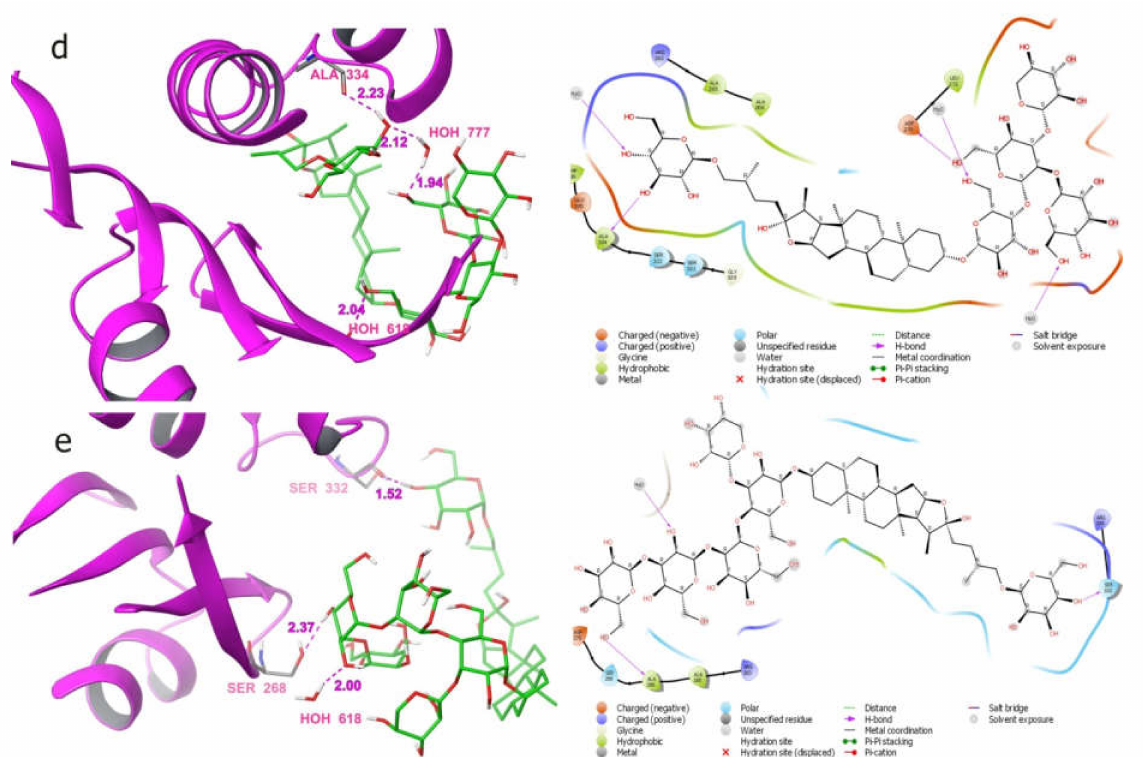
Figure 8. Sativoside R2 ( a ), Degalactotigonin ( b ), and Eruboside B ( c ) interaction map with the protein anthranilate phosphoribosyltransferase (3R6C); Proto-Degalactotigonin ( d ), and Sativoside R1 ( e ) interaction map with the protein Anthranilate phosphoribosyltransferase